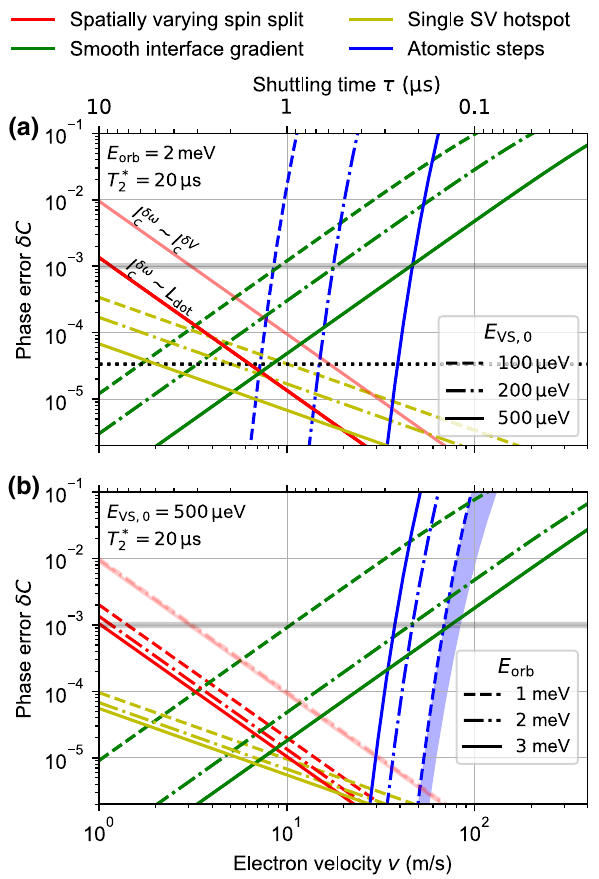
FIG. 15. Expected loss of spin coherence δ C experienced by an electron shuttled through 10- µ m-long SQS as a function of electron velocity v (lower axes) and shuttling time τ (upper axes). We compare various contribution to such an error: spatial variation of precession frequency (red lines, Sec. IV), single spin-valley hotspot due to intrinsic spin-orbit coupling (yellow, Sec. VII E) and nonadiabatic effects in valley degrees of freedom caused by smooth gradient (green, Sec. VII B) and sharp atomistic steps (blue, Sec. VII C). We distinguish between the magnetic noise due to nuclear spins (darker red line) and the charge noise (lighter red line). We highlight that hotspot contribution is the only one caused by spin-relaxation process, for which δ p ↑ ∼ δ C . The corresponding error should be multi- plied by the number of hotspots in the SQS (i.e., no hotspots for E Z (cid:6) E VS ). (a) δ C for relevant values of effective valley splitting E VS,0 = 100, 200, 500 µ eV (dashed, dashed-dotted, and solid = 20 µ s. (b) lines, respectively) for fixed E orb = 2 meV and T ∗ 2 = 1, 2, 3 meV δ C , but for different values of orbital energy E orb (dashed, dashed-dotted and solid lines, respectively) for fixed = 20 µ s. The results are values of E VS,0 = 500 µ eV and T ∗ 2 drawn for the gradient of a x ≈ 0.05 π/ nm (corresponding to intentional miscut angle ϑ ≈ 0.5 ◦ ), average step separation d = 30 nm ( ϑ ≈ 0.25 ◦ ) and magnetic field of B = 100 mT. The effect of decreasing magnetic field to B = 20 mT is illustrated by a shaded regions. For plotted range of velocities v (cid:6) L dot E orb / (cid:2) , δ C due to orbital nonadiabaticity is exponentially small. For comparison in (a) we use a black, dotted line to plot probability of spin relaxation during the transfer from Ref. [33] and Eq.